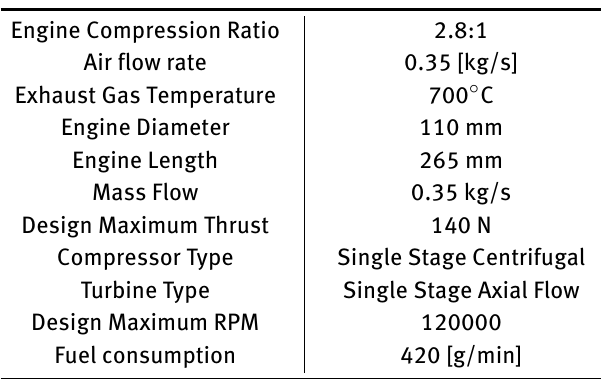
Table 1: The rated operation conditions for the GTM-140 Turbojet Engine specified by the